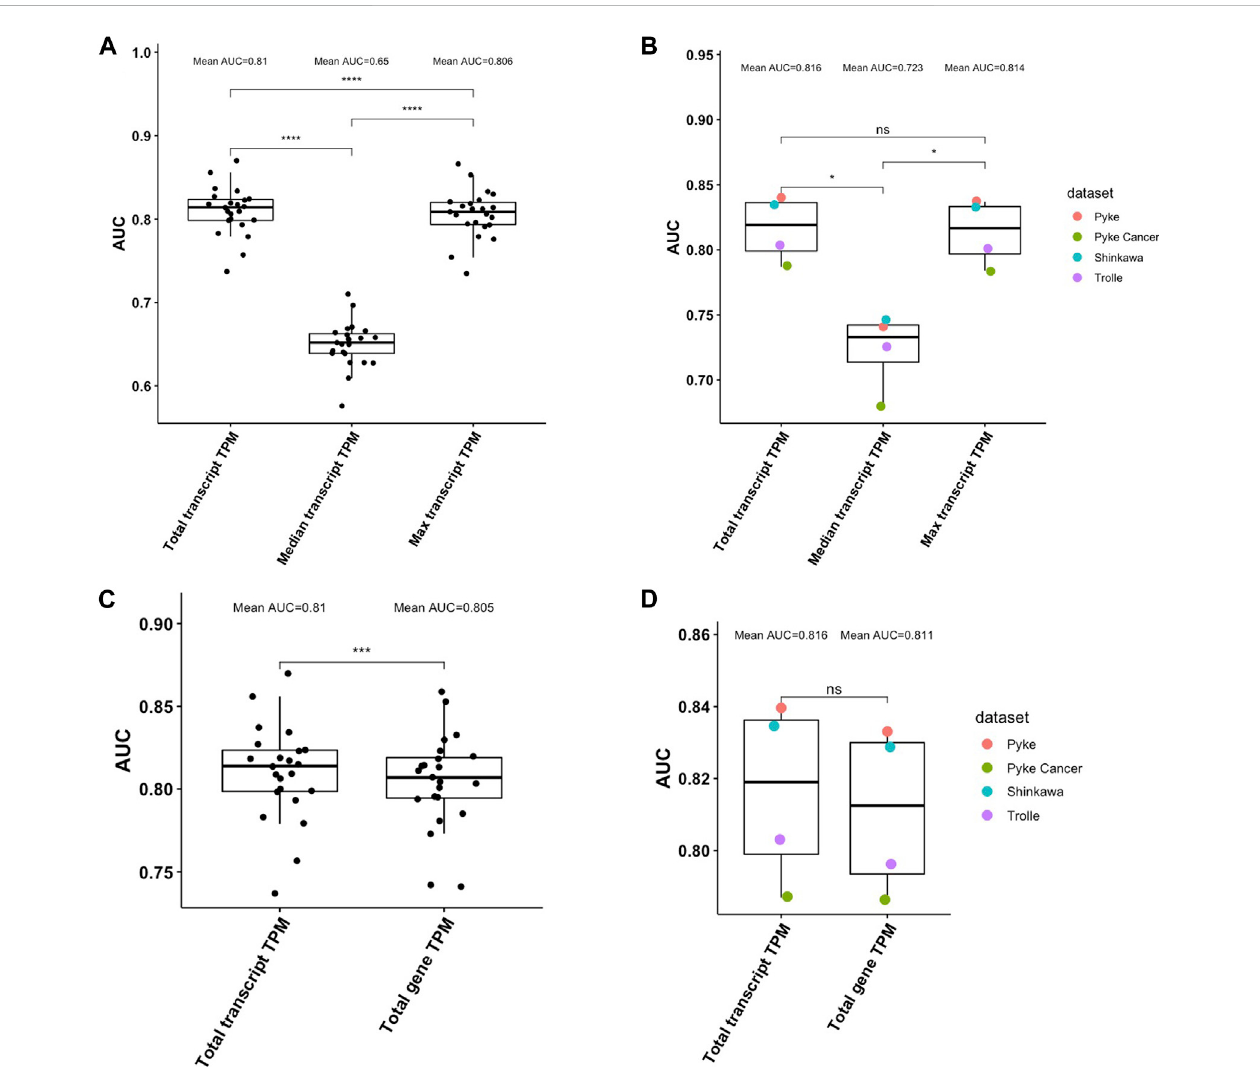
FIGURE 4 (A) . Performance comparison of different ways to aggregate transcript-level TPM values of multiple source proteins in distinguishing ligands of the HLA